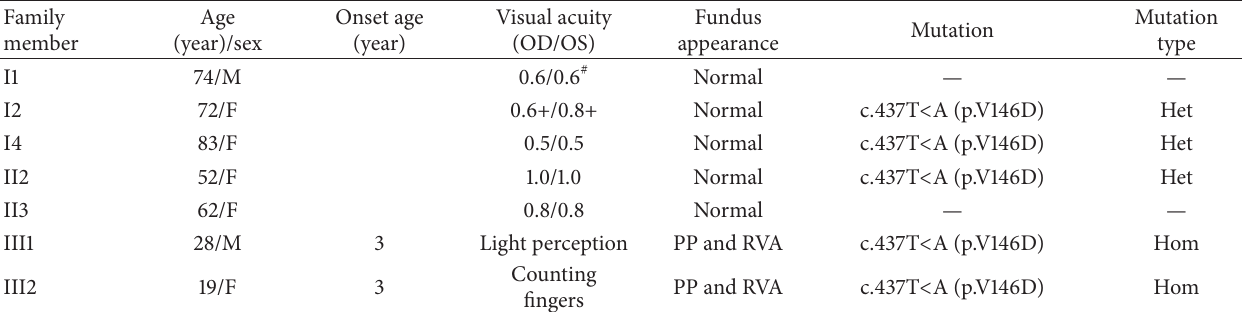
Table 1: Family member phenotypes and